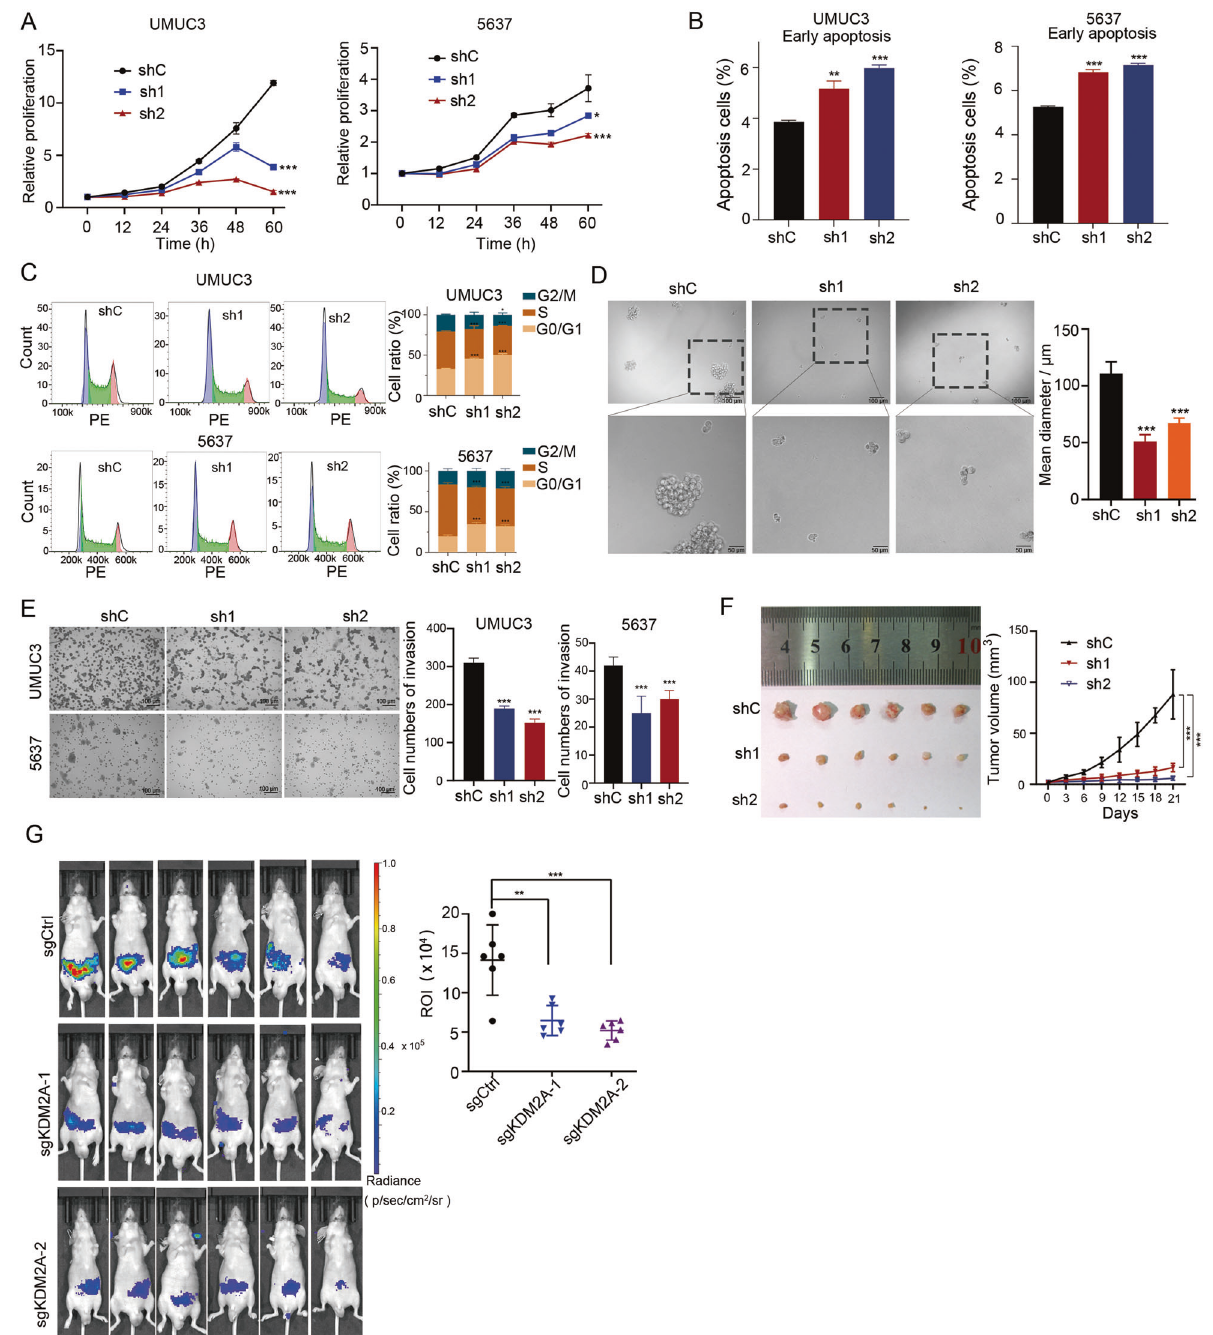
Fig. 3 KDM2A KD suppressed bladder cancer cell proliferation and migration. A Cell viability assays to investigate the proliferation ability of UMUC3 and 5637 cells that stably transduced with non-targeting scrambled control shRNA (shCtrl) or two KDM2A shRNAs (shKDM2A-1 and shKDM2A-2). B , C Flow cytometry analysis of early apoptosis staining by annexin V and PI and cell cycle staining by PI in UMUC3 and 5637 cells upon KDM2A KD. D Sphere-forming assay was performed on UMUC3 cells following KDM2A KD. The sphere size was measured on day